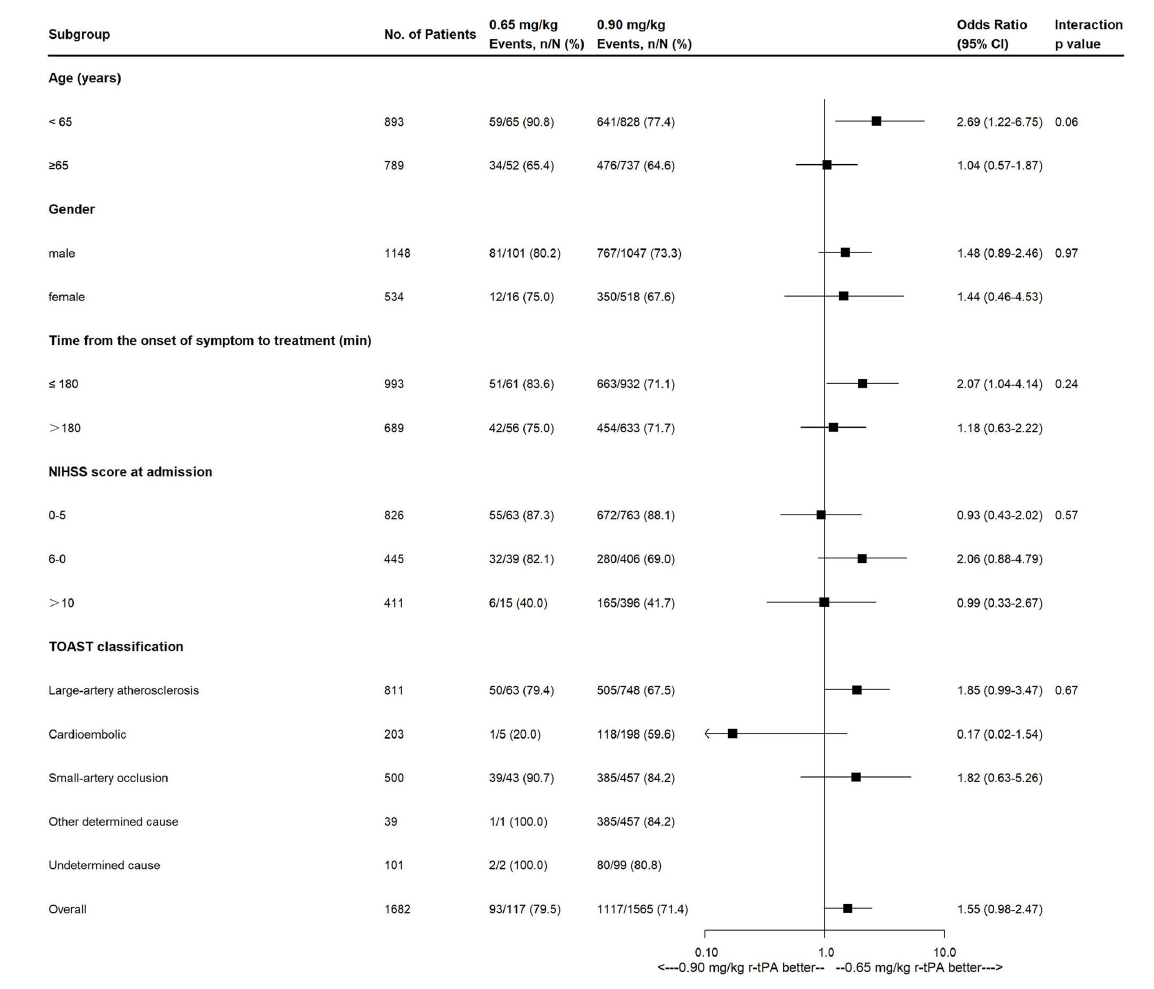
FIGURE3 Effects of 0.65 mg/kg as compared with 0.9 mg/kg on excellent functional outcome according to prespecified subgroups. NIHSS, National Institutes of Health Stroke Scale; TOAST, Trial of Org 10172 in Acute Stroke Treatment